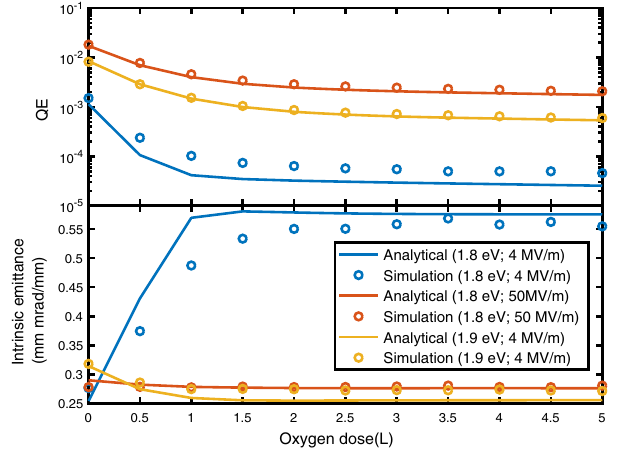
FIG. 4. The development of QE and intrinsic emittance of Cs 3 Sb in the oxygen enriched environment with different incident photon energy and applied electric field. 1 Langmuir equals to 10 − 6 Torr typical values for the DC gun and rf gun, as presented in Fig. 4. In simulation, every photoelectron ’ s initial state is recorded and the ratio from the acceptor level is obtained,